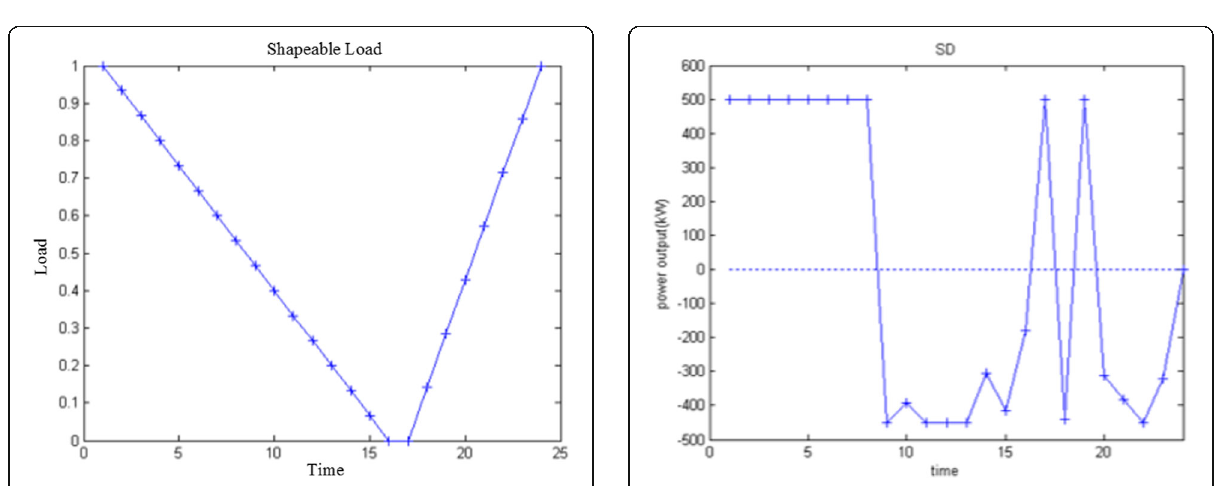
Fig. 14 Active-reactive power schedules of the